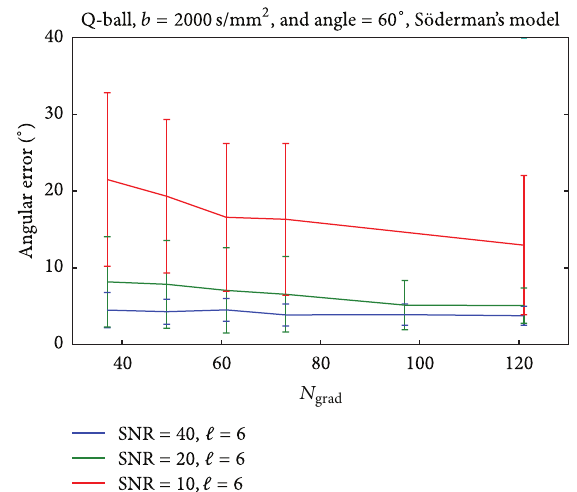
Figure 3: Influence of the gradient sampling schemes on the accuracy of Q-ball imaging for angle of 60 ∘